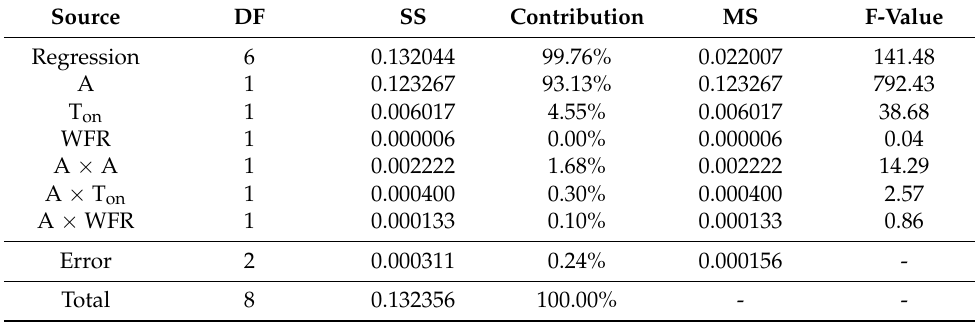
Table 7. Analysis of variance: kerf width—Al6351–5% SiC–6% B4C.